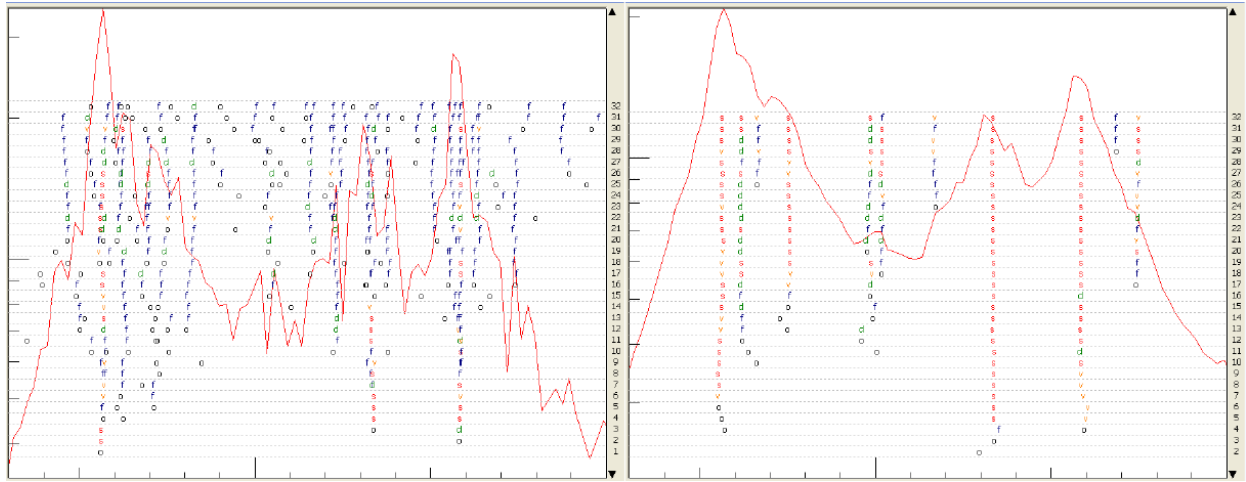
Figure 8. Stabilisation diagram using SSI (left) and PolyMAX (right) (Peeters and Van der Auweraer, 2005).